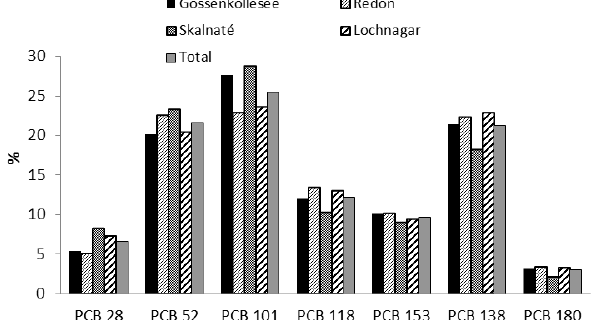
Figure 1. Mean percentage contribution of PCB congeners for all deposition samples (total) and for each study site.